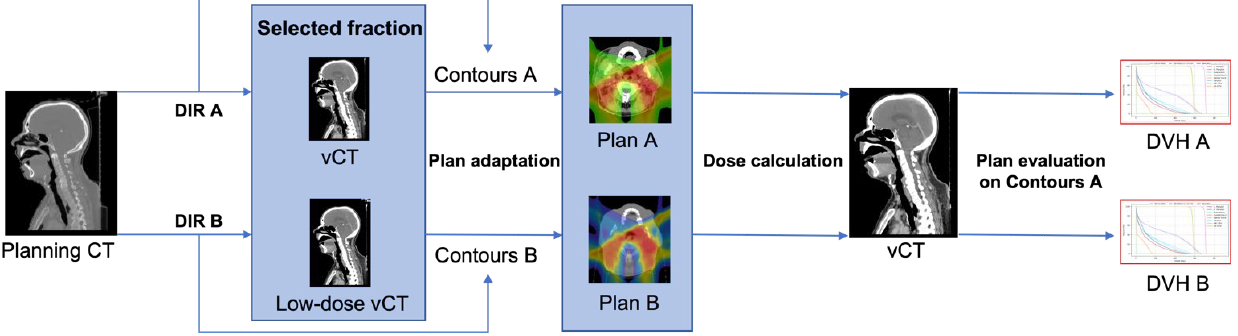
Figure 5. Overview of the methodology to assess the influence of CT scanning protocols on adaptive